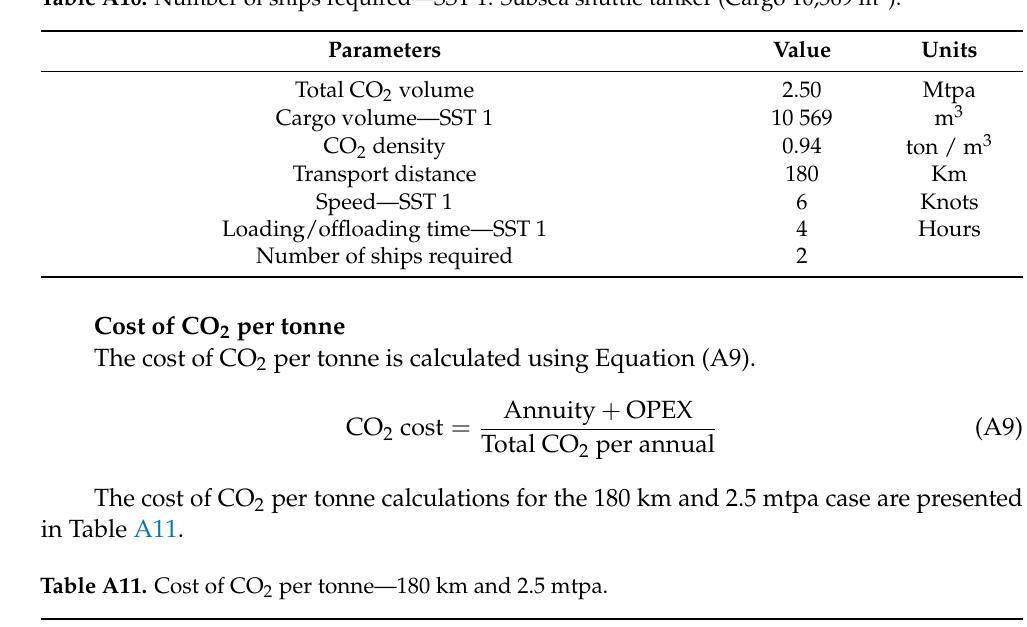
Table A10. Number of ships required—SST 1: Subsea shuttle tanker (Cargo 10,569 m 3 ).